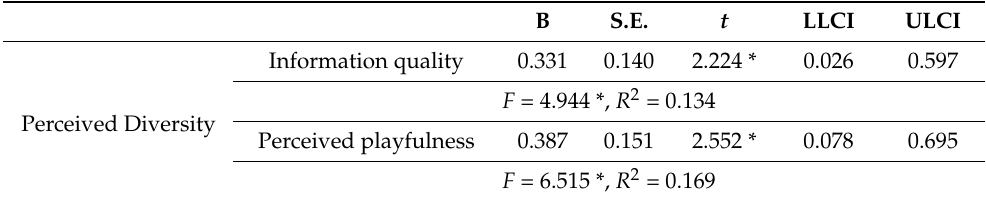
Table 2. Results of the mediation analyses of the effects of perceived diversity on two mediating variables for H1a and H1b. B S.E. t LLCI ULCI Information quality 0.331 0.140 2.224 * 0.026 F = 4.944 *, R 2 = 0.134 Perceived Diversity Perceived playfulness 0.387 0.151 2.552 * 0.078 F = 6.515 *, R 2 = 0.169